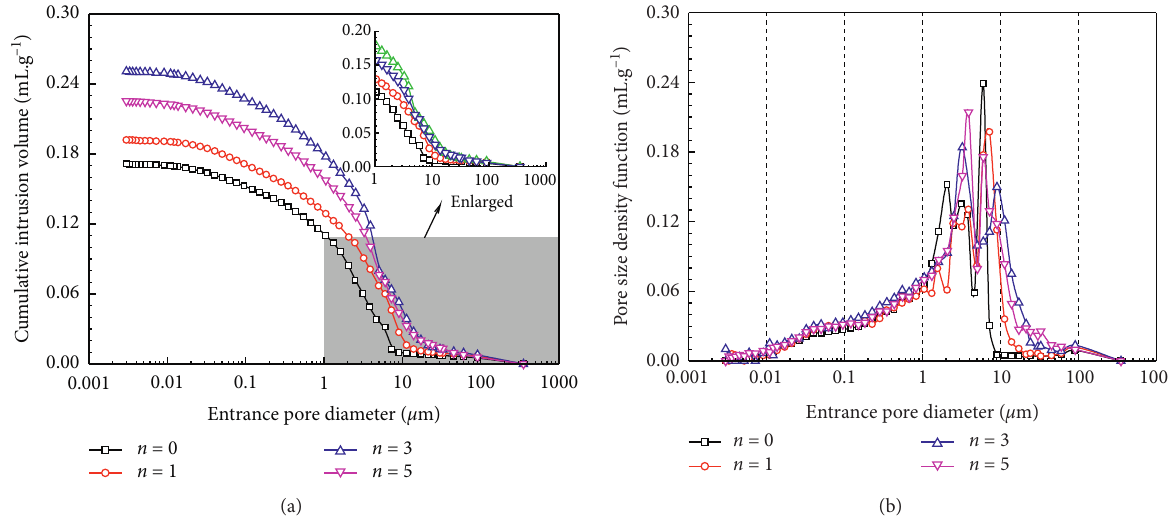
Figure 5: MIP test results on compacted loess specimens subjected to different numbers of wetting-drying-freezing-thawing cycles. (a) Cumulative intrusion curve. (b) Pore size density functions.